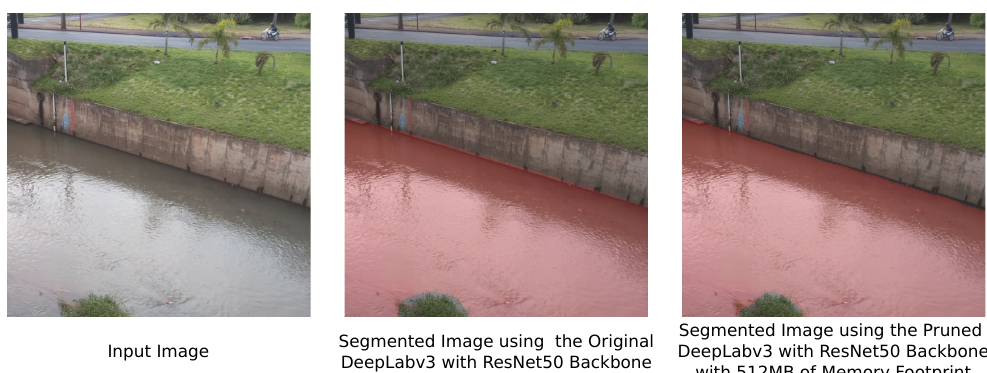
Figure 16. Semantic segmentation results of the pruned DeepLabv3 with ResNet50 backbone model with 512 MB of memory